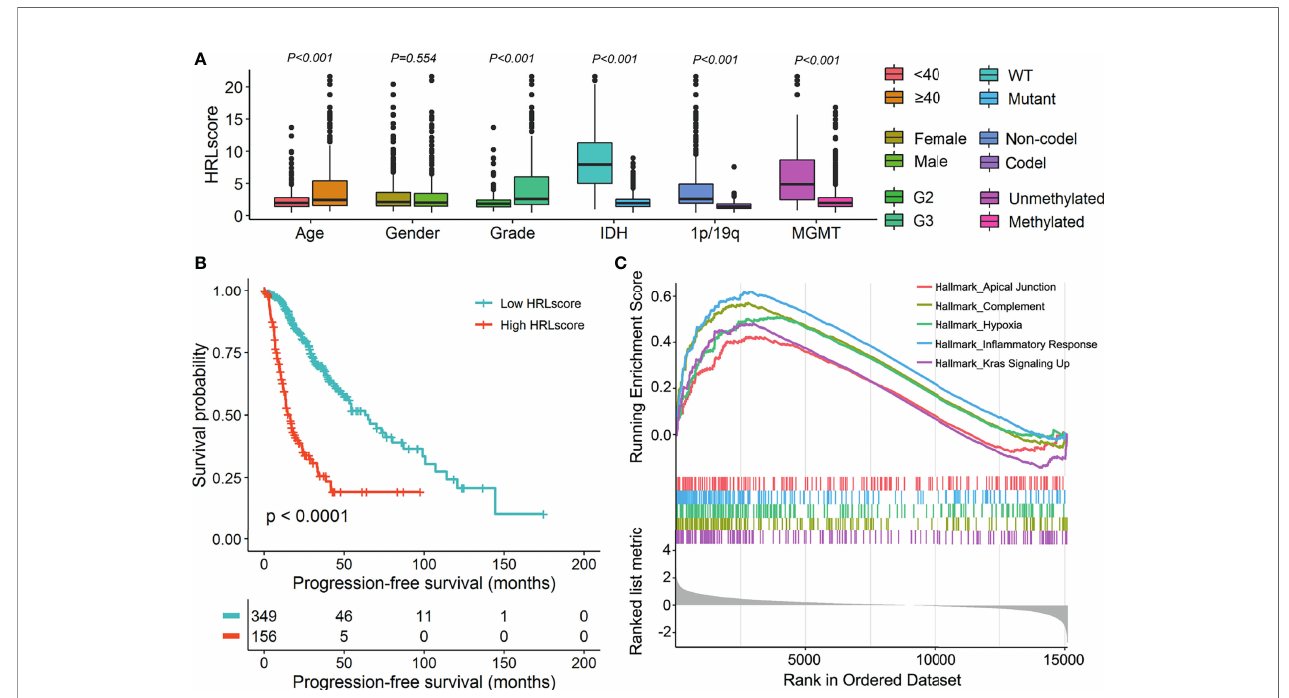
FIGURE 4 | Clinical and functional implication of the HRL signature. (A) Comparison of the HRLscore between patients with different clinicopathologic features. (B) Progression-free survival curves for patients in the TCGA-LGG cohort. (C) Enrichment plots from GSEA for the comparison between patients with high and low